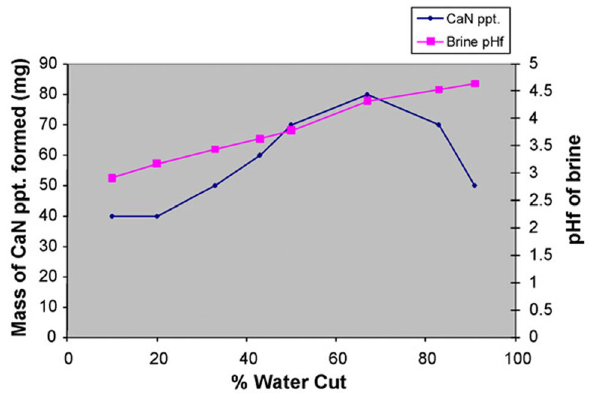
Fig. 8 Influence of water cut on amount of calcium naphthenate pre- cipitate and brine pH (Mohammed and Sorbie